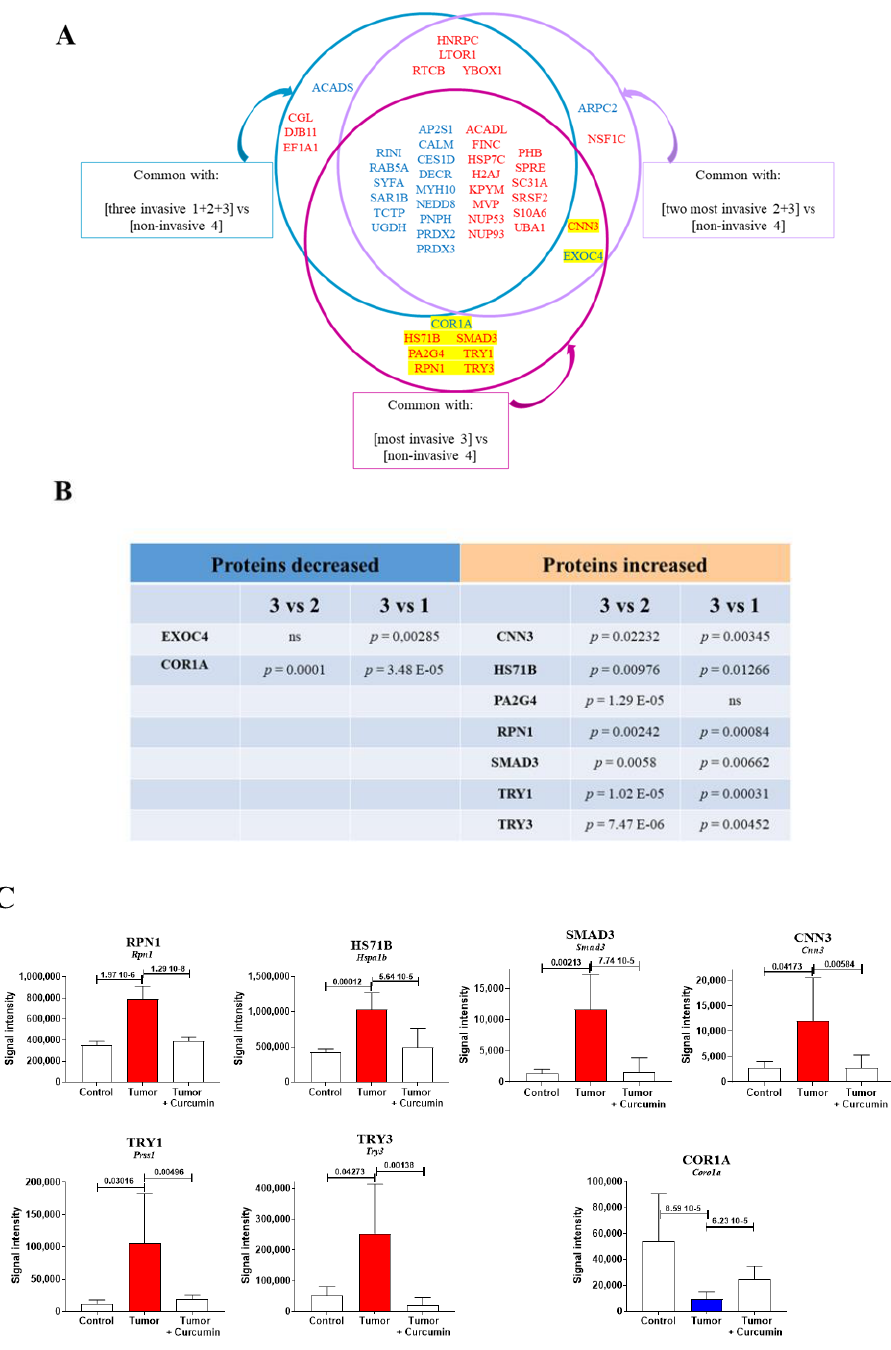
Figure 6. Common biomarkers of liver colonization by M5-T1 cells and the M5-T1 tumor. ( A ) Schematic representation of the method used to identify biomarkers common to the liver colonization by M5-T1 tumor cells and invasive rat mesothelioma tumors. The lists of proteins common to each condition are written in blue (for decrease) and red (for increase). The codes describing each invasive rat mesothelioma tumors were: 1 = F4-T2, 2 = F5-T1, and 3 = M5-T1 (4 = noninvasive M5-T2). As in Figures 3–5, the equivalent human genes that encode the proteins represented by abbreviations (for the rat) are given in Tables S1 and S2. ( B ) The p -values for the nine biomarkers identified in ( A ), highlighted in yellow (MarkerView statistical analysis) when comparing abundance changes in 3 vs. 1 and 3 vs. 2 (same codes for the rat tumors as above). ( C ) Comparison of protein abundances between the three groups of rats (significant increases in red and decreases in blue, with p -values indicated above bars) for the seven biomarkers satisfying the condition p < 0.05 in the two tests described in ( B ).